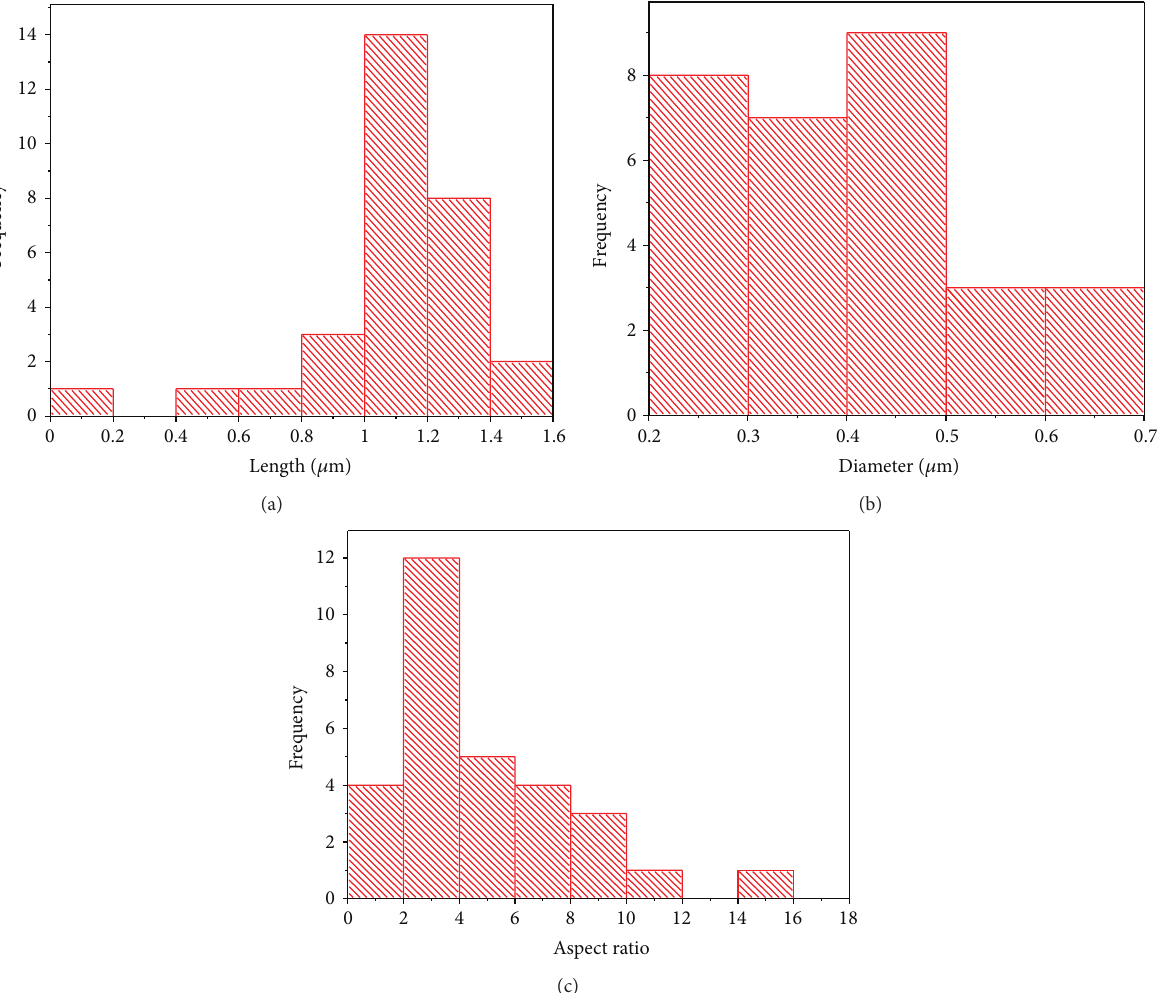
Figure 4: Histogram of ZnO NRs that are grown on stainless steel wire: (a) length, (b) diameter, and (c) aspect ratio (650 ∘ C, 2 sccm O 2 , and 0.3 g Zn